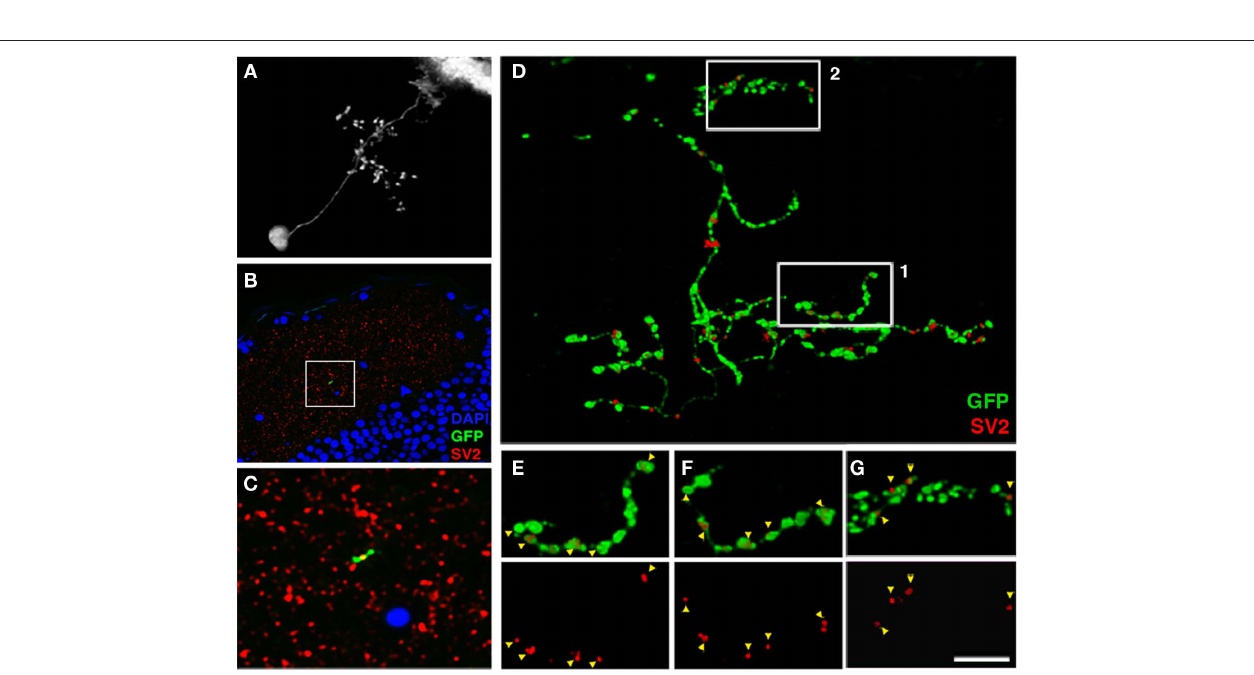
FiGure 5 | The bistratified periventricular interneuron cell type. (A) Merged confocal image volume of a single 4 dpf bsPVIN expressing both dsRed (red) and Syp–GFP (green). (B) 2 × magnification of bracketed region in (A) . (C) Syp–GFP fluorescence of region in (D) . Note the bright Syp–GFP puncta located within the arbor that targets the deeper synaptic